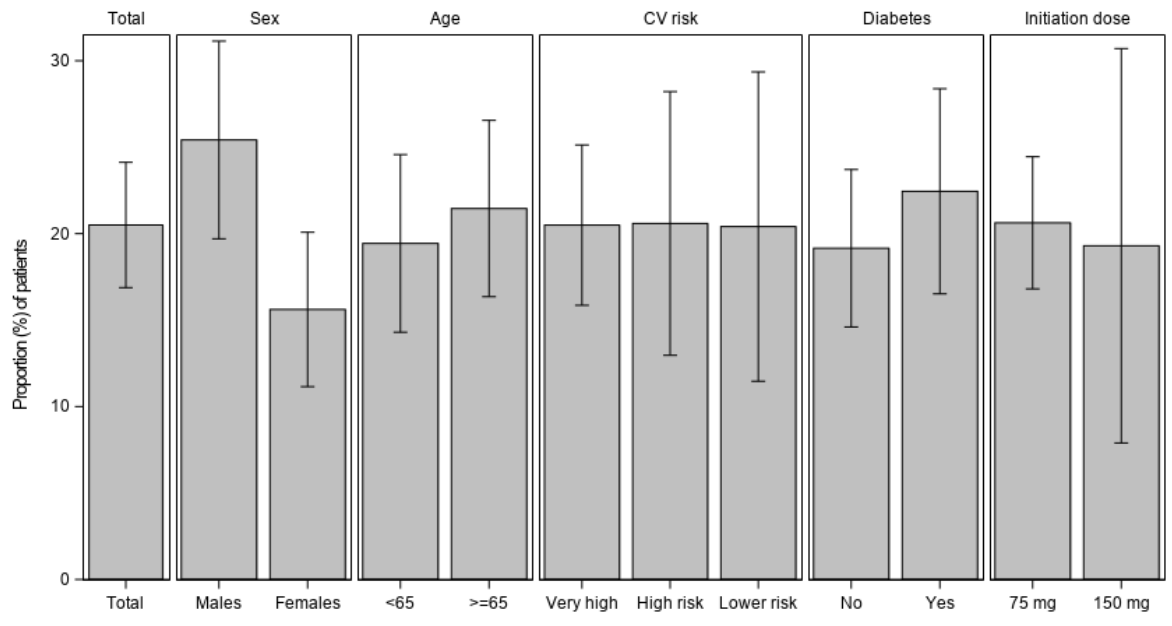
Figure 3. Proportion (%) of patients achieving LDL-C goals during study period. Proportion of patients and 95% confidence intervals of patients achieving LDL-C target goals according to 2019 ESC/EAS guidelines. Abbreviations: CV: Cardiovascular; LDL-C: Low-density lipoprotein cholesterol.